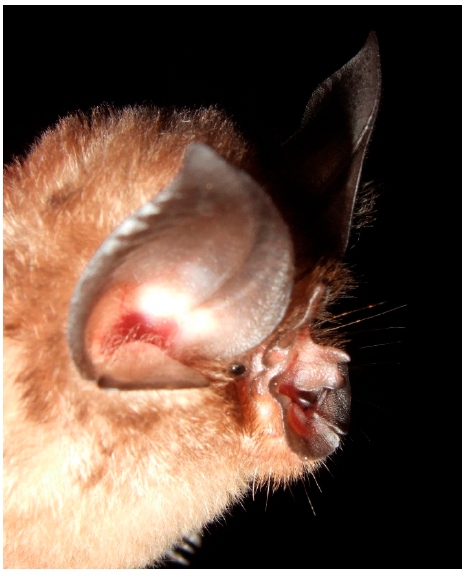
Figure 9. Rhinolophus pusillus , adult male. Photograph by Vu Dinh Thong.